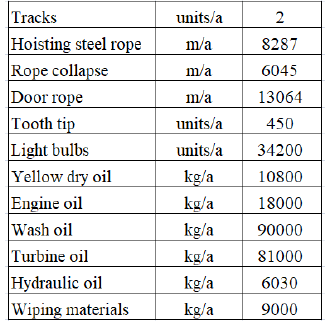
Figure 6. Output interface of equipment selection and matching results.